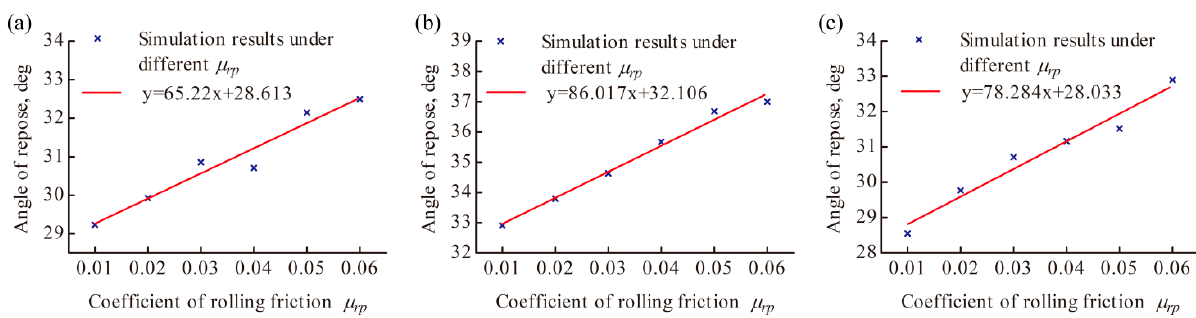
Figure 12. Calibration of the coefficient of rolling friction between seed particles for three maize varieties for three varieties: ( a ) Liangyu99, ( b ) Xianyu 335 and ( c ) Zhengda 999.